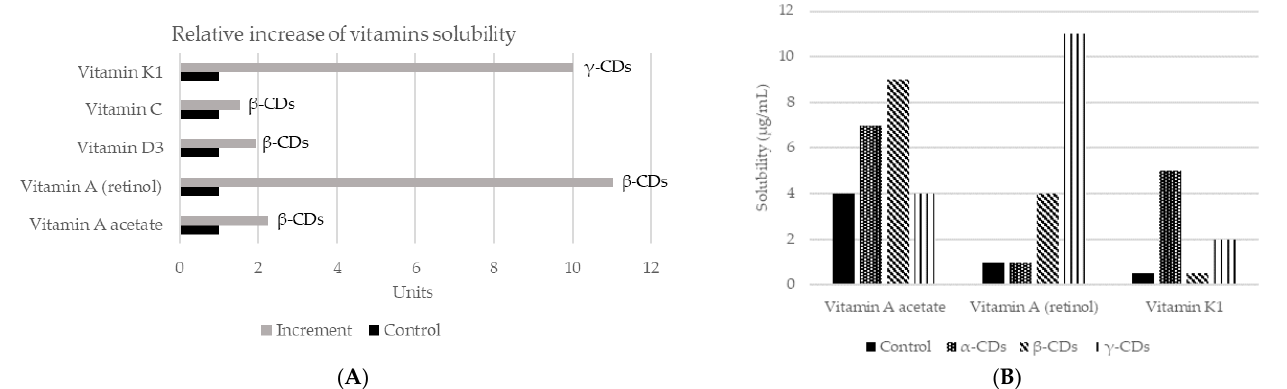
Figure 3. Changes in solubility in water of different vitamins according to the use of different CDs. ( A ) Relative increase of the solubility of vitamins using different CDs complexes. Adapted from [74,75]. ( B ) Vitamins solubility (µg/mL) when the three main types of CDs applied in a concentration of 5%, using saline solution as control and measured by mass spectrometry [74]. More recently, new studies have assessed the solubility of vitamin E + large ring cyclodextrins [76] and vitamin A together with β -CDs [77].